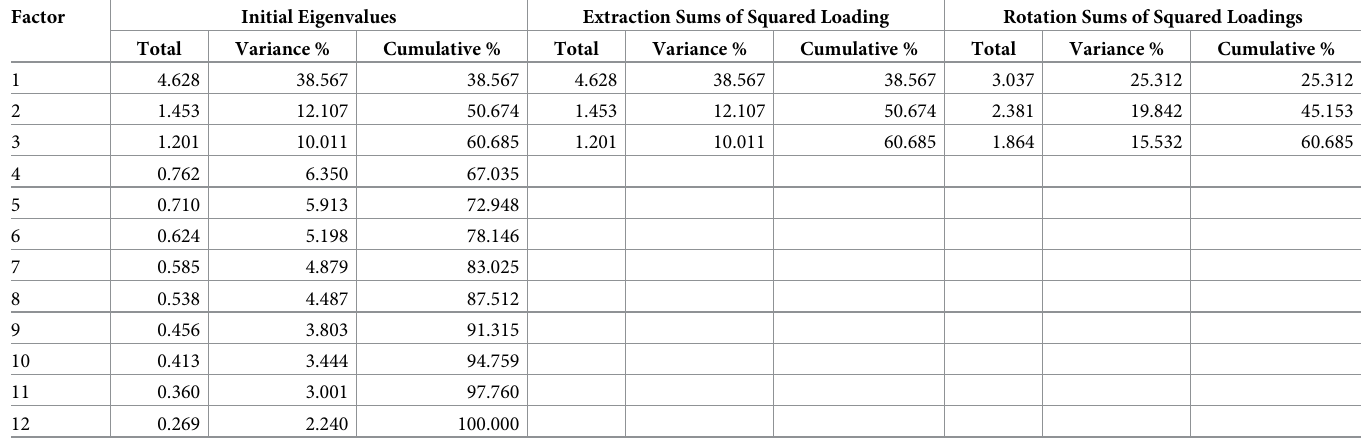
Table 3. Total explained variance from the exploratory factor